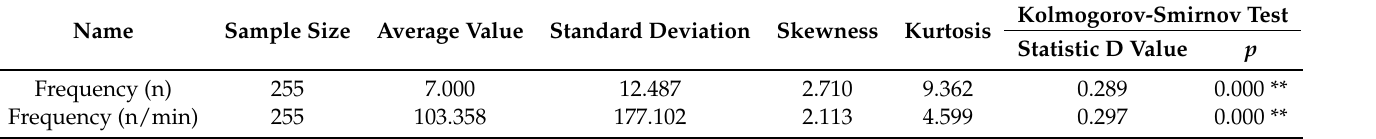
Table 22. Normality test of saccade data of different size